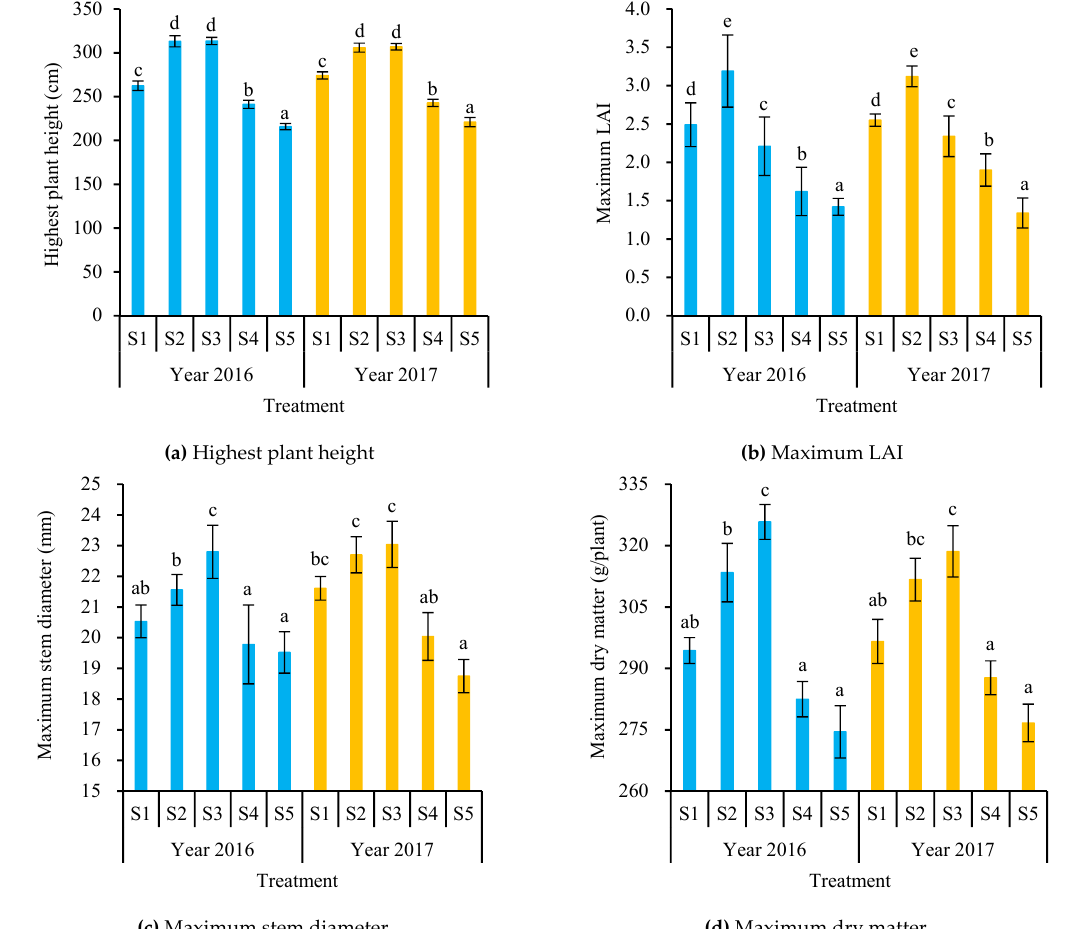
Figure 5. Main maize vegetative growth characteristics for the different salinity irrigation water treatments in 2016 and 2017. Note: The same letter above the error bars in same year represents no significantly different at p ≤ 0.05.